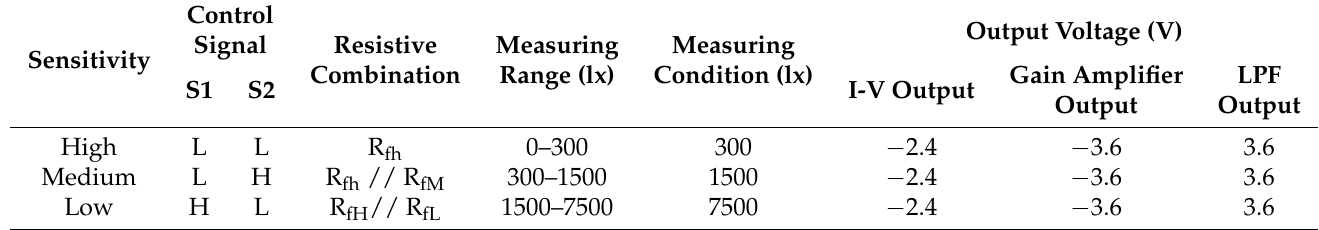
Table 2. Output of the TIA, GC, and LPF.